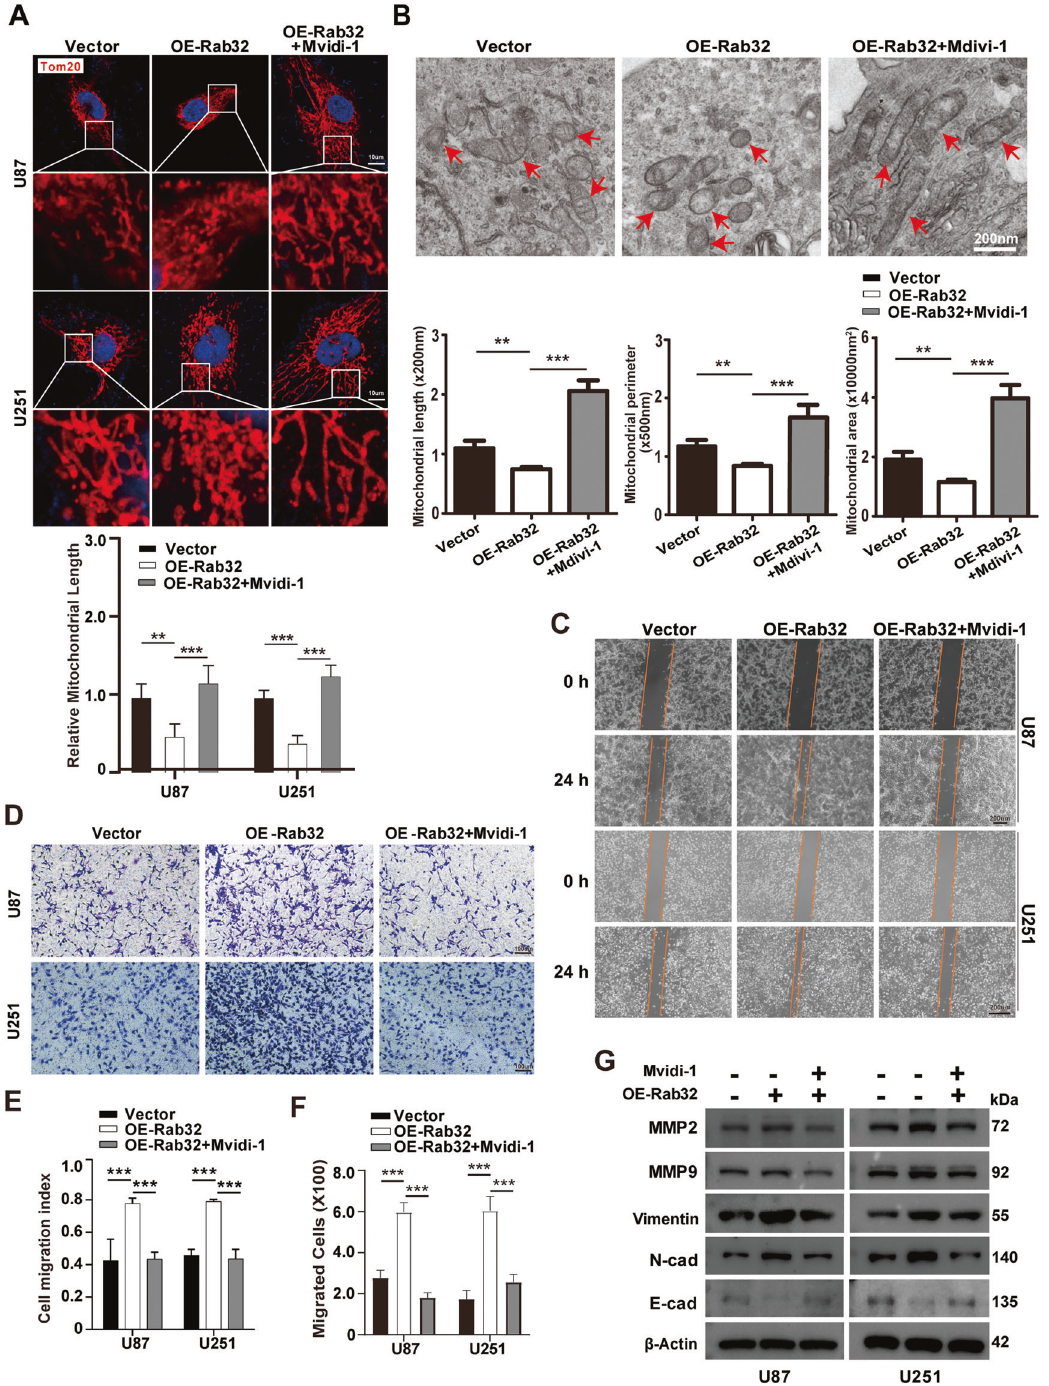
Fig. 4 Drp1 inhibitor attenuates the effect of Rab32 overexpression on GBM malignancy. The U87 and U251 were transfected with OE- Rab32 plasmid and then treated with 50 μ M Mdivi-1 for 24 h. A Representative immuno fl uorescence images of the mitochondrial network (upper panel) in treaded U87 and U251 cells. Red: Tom20, Bule: DAPI. Areas in the white squares are ampli fi ed and shown in the middle. The length of mitochondria was quanti fi ed by Image J (lower panel). Scale bar = 10 μ m. N = 30 per group. Data shown are mean ± SD. B TEM photomicrographs of U87MG cells with Rab32 knockdown or overexpression (upper panel). Quanti fi cation of mitochondrial length, perimeter and area using ImageJ software (lower panel). Mitochondria are highlighted in red arrows. N = 30 per group. Data shown are mean ± SD. C The migratory ability of cells was analyzed using a wound-healing assay. Scale bar = 200 μ m. D A transwell invasion assay evaluated the invasive capacity of cells. Representative images of cells crossing the membrane are shown. Scale bar = 100 μ m. E , F Quantitative analysis of glioma cells ’ migratory and invasive capacity in C and D , respectively. G Western blotting analysis was performed to detect the level of MMP2, MMP9, Vimentin, N-cadherin, and E-cadherin. β -Actin was used as a loading control. The data are shown as the mean ± SD of three replicates. ** P < 0.01, *** P < 0.001 vs. NC